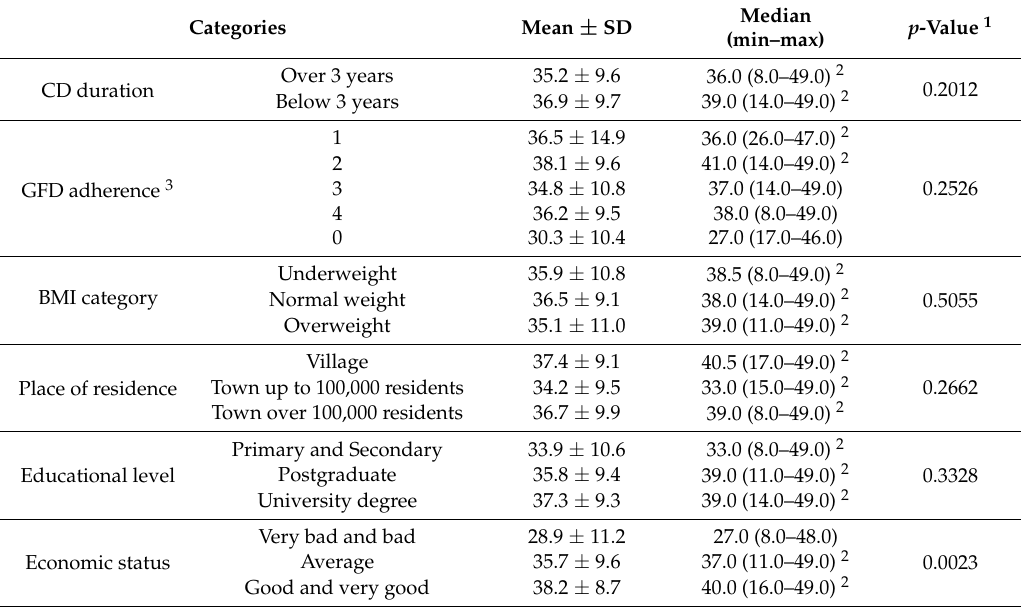
Social subscale data categorized by CD duration, GFD adherence, BMI and sociodemographic